Question: Identify the chart type used in this figure.
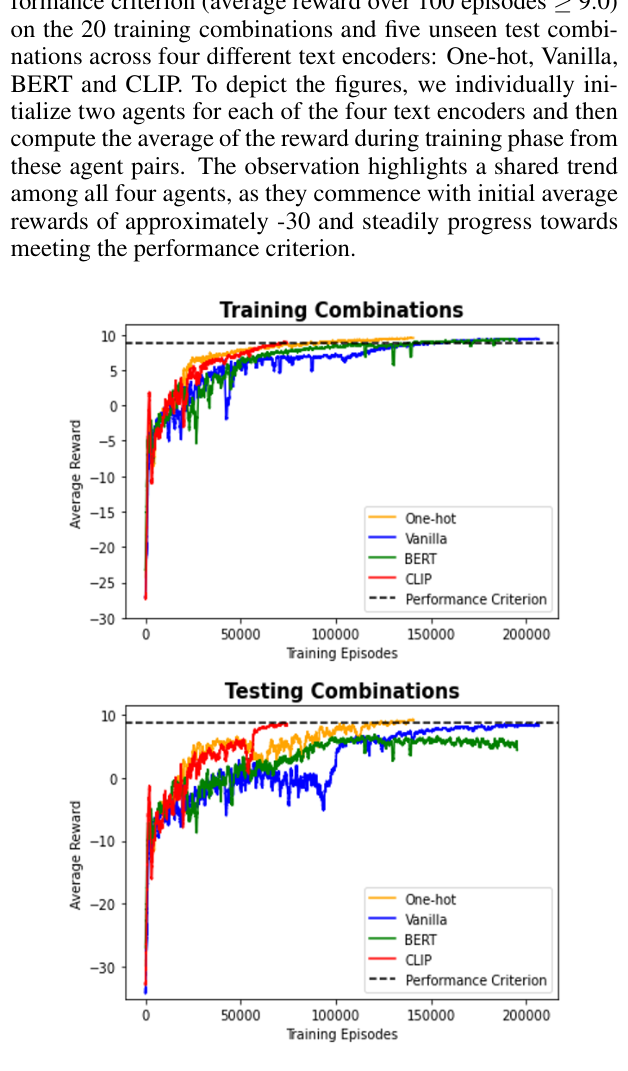
Answer: line